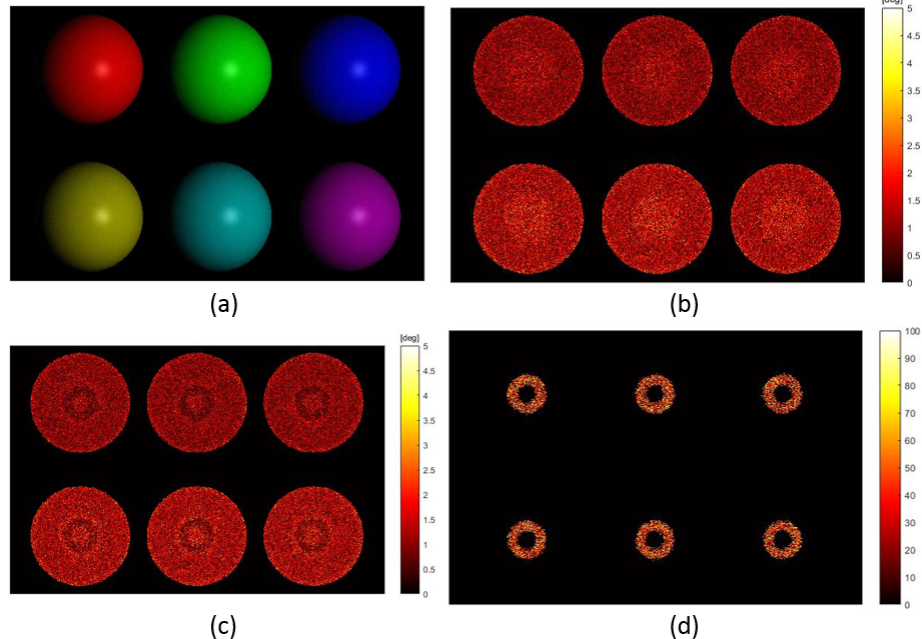
Figure 4. Evaluation of surface normal refinement: ( a ) Image irradiance under the first illuminant; ( b ) Angular error of surface orientations without surface normal refinement in degrees; ( c ) Angular error of surface orientations with surface normal refinement in degrees; ( d ) Improvement of surface orientation estimation by including surface normal refinement in